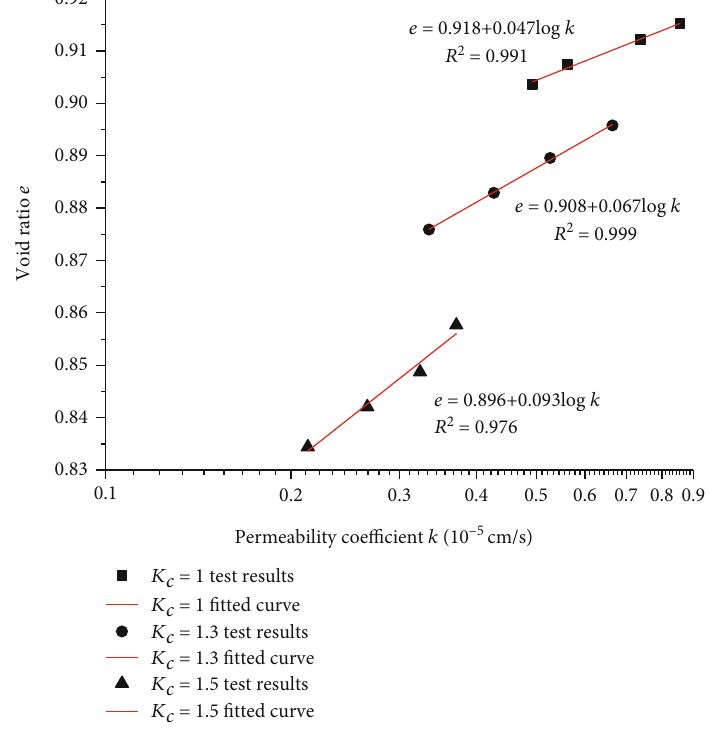
Figure 10: e ‐ log k